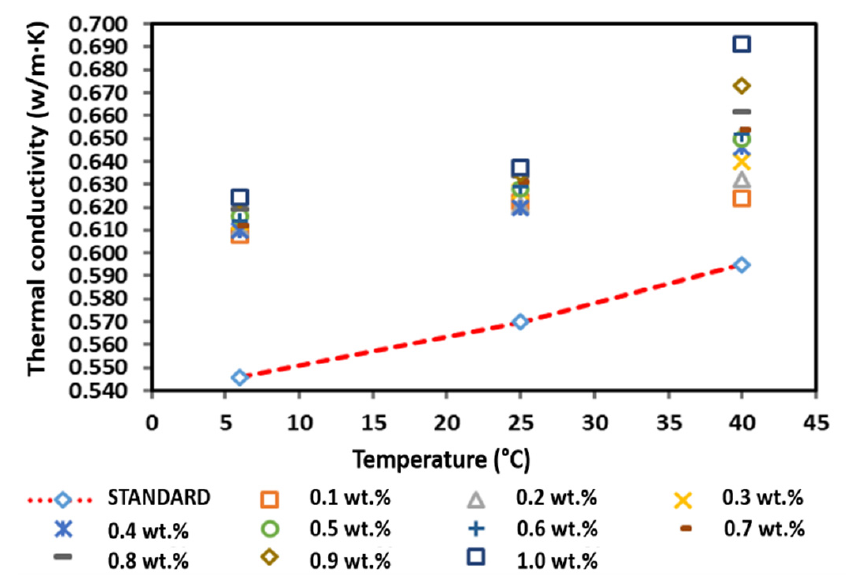
Figure 15. Comparison of the thermal conductivity between the surface-oxidised CNF-based nanofluid without PVP and the pure base fluid at various concentrations and temperatures. Table 7. Thermal conductivity enhancement of the surface-oxidised CNF-based nanofluids without PVP. Weight Concentration of Surface-Oxidised CNFs